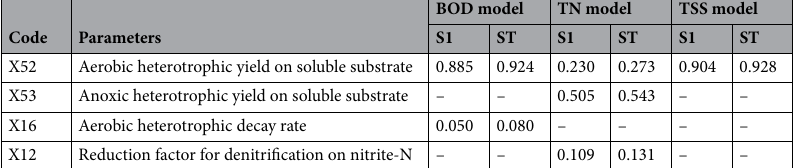
Table 4. Parameters identified as influential by the Sobol analysis (> 0.05) with observed Sobol indices for first and total order effects. All results displayed demonstrate a 95% confidence level.